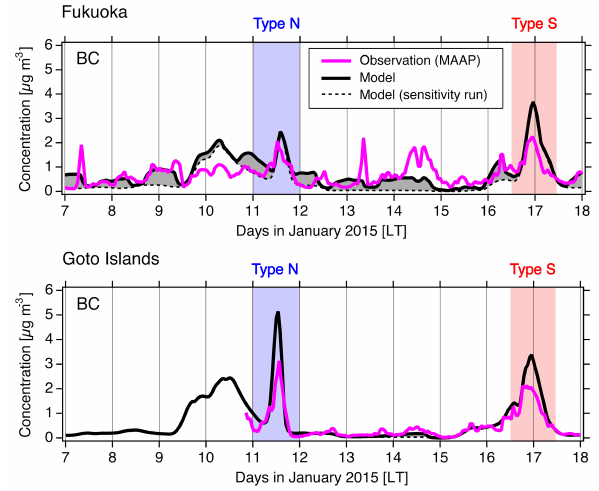
Figure 8. The temporal variation in BC at Fukuoka and the Goto Islands from 7–17 January 2015. The blue and red shading shows the type N and S patterns focused on in this study. The magenta line indicates BC observations by MAAP. The black lines indicate the base case simulation, and the dotted black lines indicate the sensi- tivity simulation in which the anthropogenic emissions from Japan were switched off; the differences between these results, shown in gray, represent local